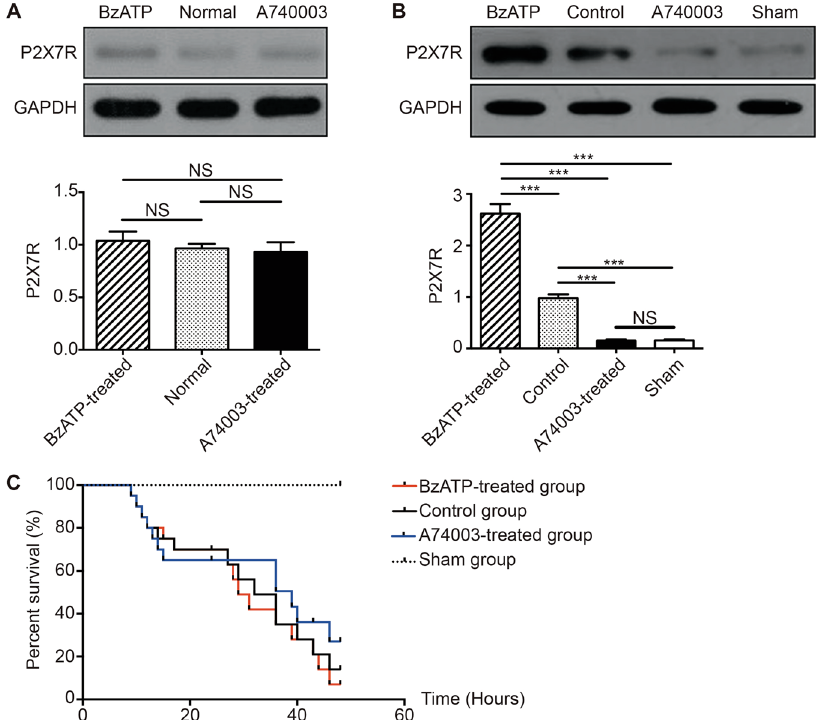
Figure 1. The effects of a P2X7R blockade on receptor expression and survival rates. The protein levels of P2X7R in intestines from mice that received intraperitoneal injections of BzATP or A740003 before CLP procedures ( A ) and 48 hours after CLP procedures ( B ) measured by WB. N = 6 mice per group. The results of the WB analysis are combined data from three densitometric scans (mean ± SD). ( C ) The Kaplan-Meier survival curve 48 hours after CLP. Twenty-four hours after CLP, mice received saline (control group, N = 20), BzATP (BzATP-treated group, N = 20), or A740003 (A740003-treated group, N = 20). The mice in the sham control group that underwent sham surgery (sham group, N = 6) were intravenously injected with saline. The Kaplan-Meier survival curves were compared by the log-rank test. * p < 0.05, ** p < 0.01 and *** p < 0.001 when compared among the different